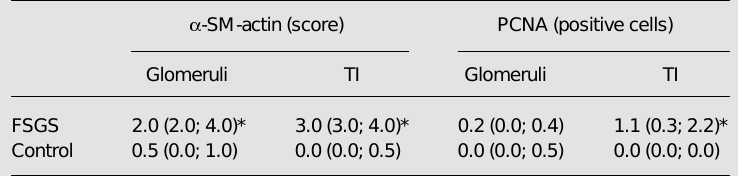
Table 1. Expression of a -smooth muscle actin ( a -SM-actin)and proliferating cell nuclear antigen (PCNA) (positive cells/glomerulus or per graded field) in glomeruli or in the tubulointerstitial area (TI) from the renal cortex of patients with focal segmental glomerulosclerosis (FSGS) and of control individuals.